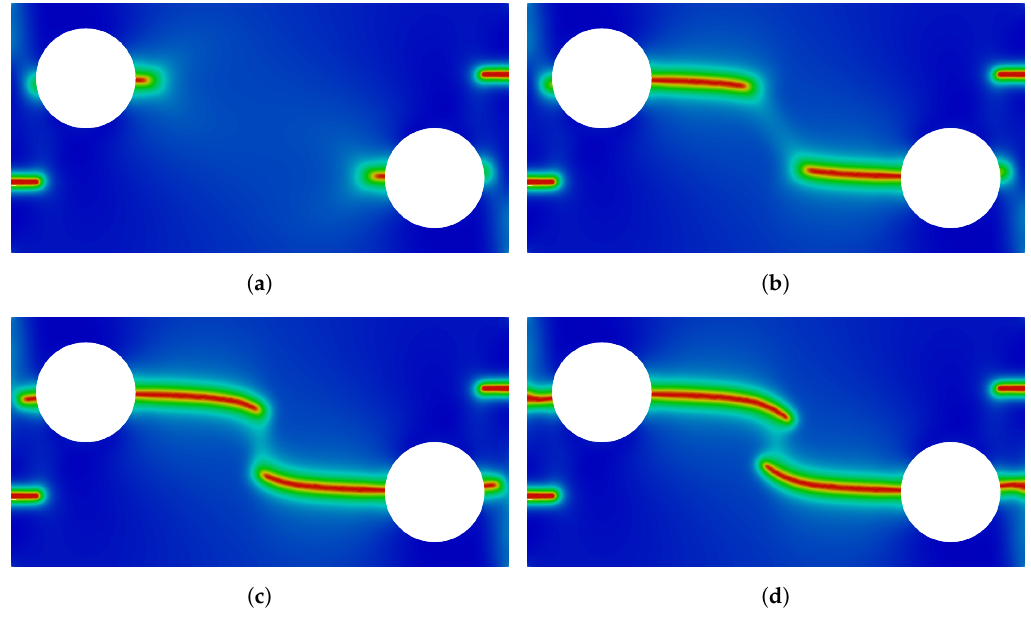
Figure 38. PFM crack path without restricting nucleation at the holes. ( a ) Cracks initiating at the holes; ( b ) Growth of cracks originating from the holes; ( c ) Additional cracks nucleate at the holes; ( d ) Nucleated cracks reach the domain